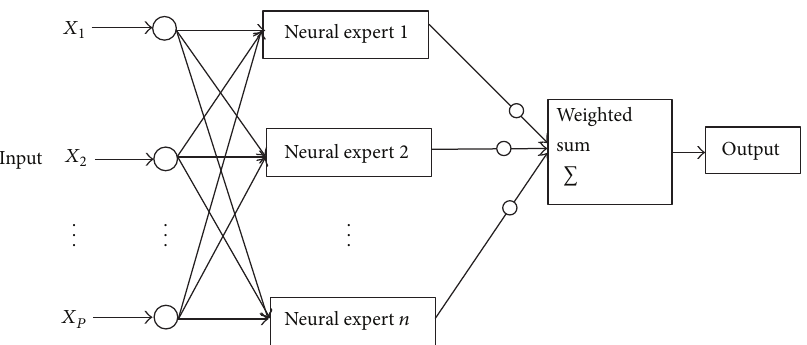
Figure 1: General construction of feedforward modular